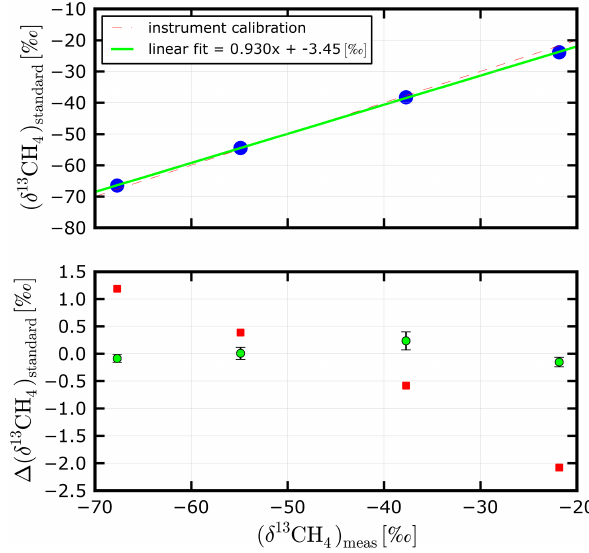
Figure 5. Results of the validation calibration experiment. Top panel: blue circles: measured isotope ratio ( x values) vs. standard values from the vendor. Green line: linear fit to these data. Red dashed line: standard instrument calibration ( A = 165 , 595 . 7 and B = − 1053 . 61), and including the loss nonlinearity term β and an optimized overall loss offset α 0 of − 0 . 0103ppbcm − 1 . Bottom panel: green circles: residuals from the green line in the top panel. The error bars indicate the standard deviation of the four concentra- tion measurements between 1.9 and 15ppm for each isotope stan- dard, but do not include the uncertainty in the standard value of 0.2‰. Red squares: difference between the measured value using the standard instrument calibration and the standard